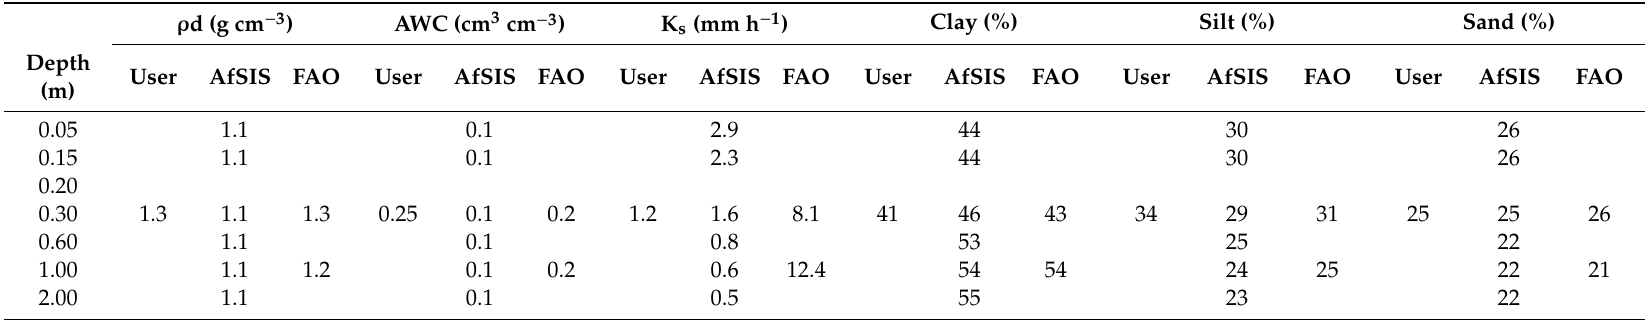
Table 1. Summary of soil physical and hydrologic properties at di ff erent depths for the user (1 depth), AfSIS (7 depths), and FAO soil databases (2 depths). ρ d, AWC, and Ks refer to bulk density, available water holding capacity, and hydraulic conductivity, respectively. Clay, Silt, and Sand refer to percentage textural